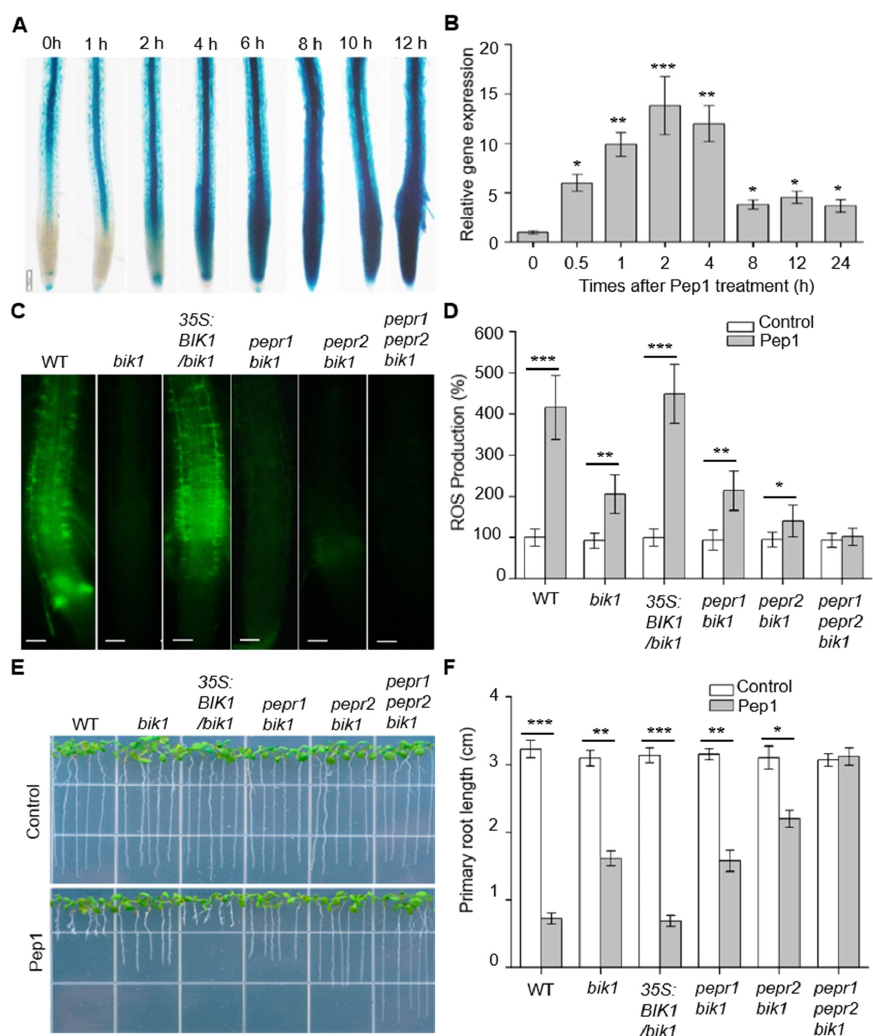
Figure 5. BIK1 is required to regulate Pep1-induced ROS production and root growth inhibition. ( A ) Histochemical staining of GUS activity in the roots of transgenic plants harboring proBIK1:GUS upon exposure to Pep1. The six-day-old plants were transferred on half-strength MS agar medium, supplemented with 1 μ M Pep1 for 1, 2, 4, 6, 8, 10, and 12 h, respectively. The experiments were repeated three times with similar observations. Bars = 200 μ m. ( B ) qRT-PCR analysis of mRNA levels of BIK1 in the wild type (WT) roots. The two-week-old plants were incubated in half-strength MS liquid medium, supplemented with 1 μ M Pep1 for 0.5, 1, 2, 4, 8, 12, and 24 h, respectively. The expression level of control (0 h) was set as 1.0 and the Pep1 treatment levels were normalized to the control level. Data are means ± SD ( n = 3). ( C ) H 2 DCF-DA staining of H 2 O 2 in WT, bik1 , 35S:BIK1 / bik1, pepr1 bik1 , pepr2 bik1, and pepr1 pepr2 bik1 roots. Six-day-old seedlings were incubated in half-strength MS liquid medium, supplemented with 1 μ M Pep1 for 18 h. The roots were stained with 30 μ M H 2 DCF-DA solution for 10 min and photographed under fluorescence microscopy (Olympus, BX53). Bars = 100 µ m. ( D ) The statistical analysis of ROS production, as indicated in ( C ). Data are means ± SD from three independent experiments. ( n = 30). The relative ROS production of each treatment was normalized to control of wild type roots (100%). ( E ) The growth phenotype of WT, bik1 , 35S:BIK1 / bik1, pepr1 bik1 , pepr2 bik1, and pepr1 pepr2 bik1 roots. The three-day-old seedlings were transplanted on half-strength MS agar medium supplemented with or without (control) 100 nM Pep1 for six days. ( F ) The statistical analysis of the primary root length, as indicated in ( E ). Data are means ± SD from three independent experiments ( n = 15). Asterisks in ( B , D , F ) indicate statistically significant di ff erences compared with the untreated controls in each genotype (Tukey’s test, * p < 0.05, ** p < 0.01; *** p <